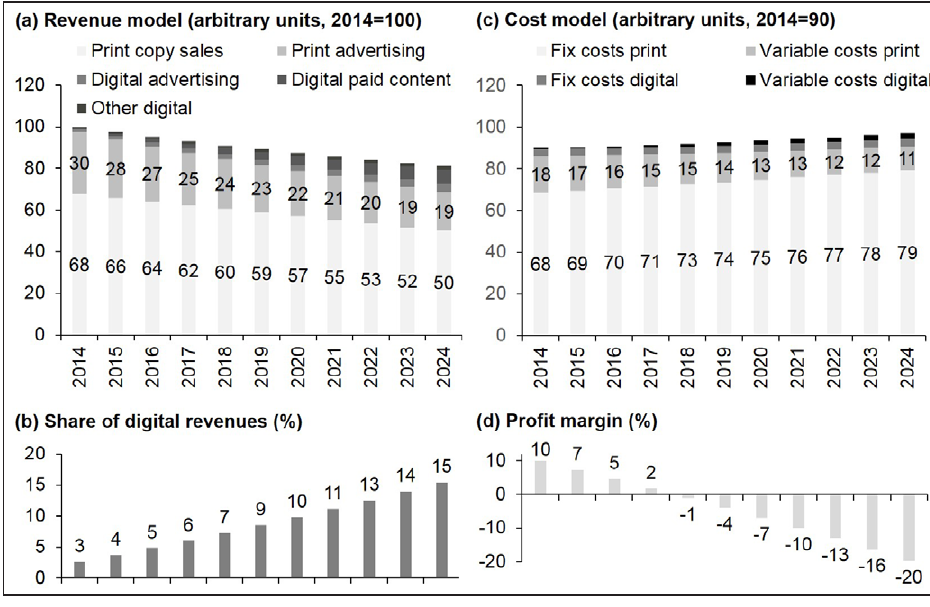
Figure 12: Exemplary revenue, costs, and profit development for an average regional newspaper. Source : Own elaboration based on model